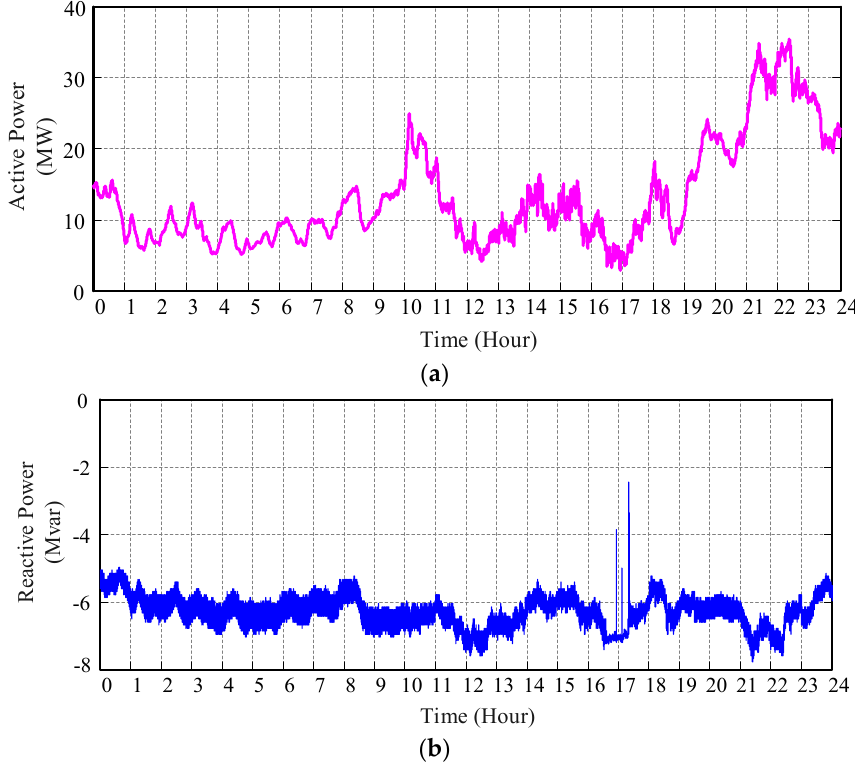
Figure 16. Wind power data in one day with a three ‐ second interval. ( a ) Active power; ( b ) Reactive power.